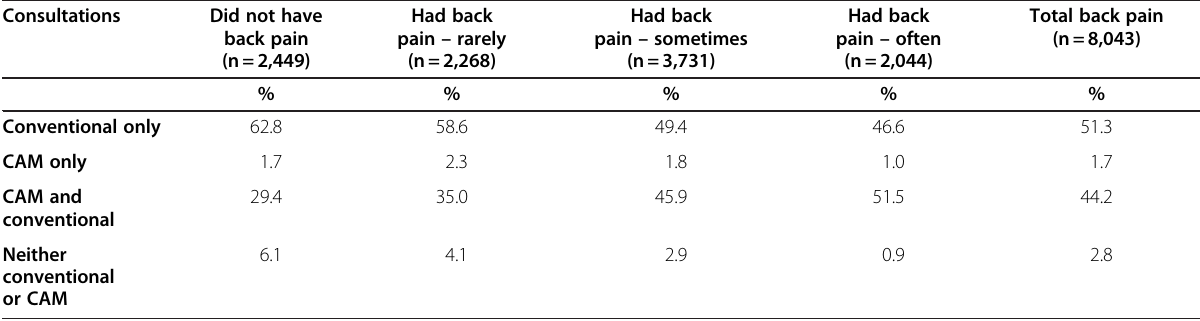
Table 1 Back pain status by consultations with conventional health care providers and CAM practitioners